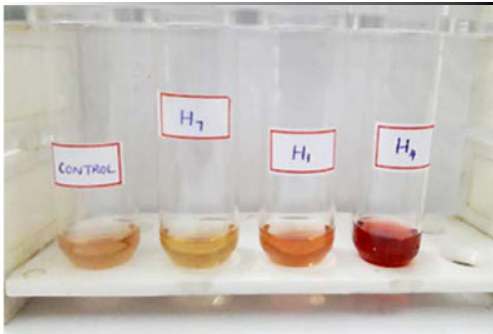
Fig. 8. Primary screening of IAA